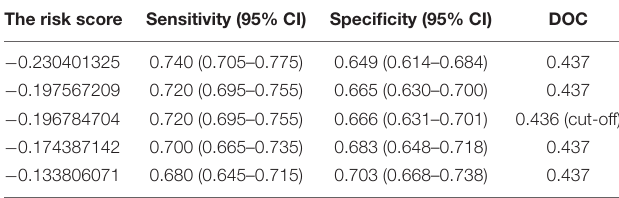
TABLE 3 | ROC curve for various cut-off levels of the risk score. The risk score Sensitivity (95% CI) Specificity (95% CI)